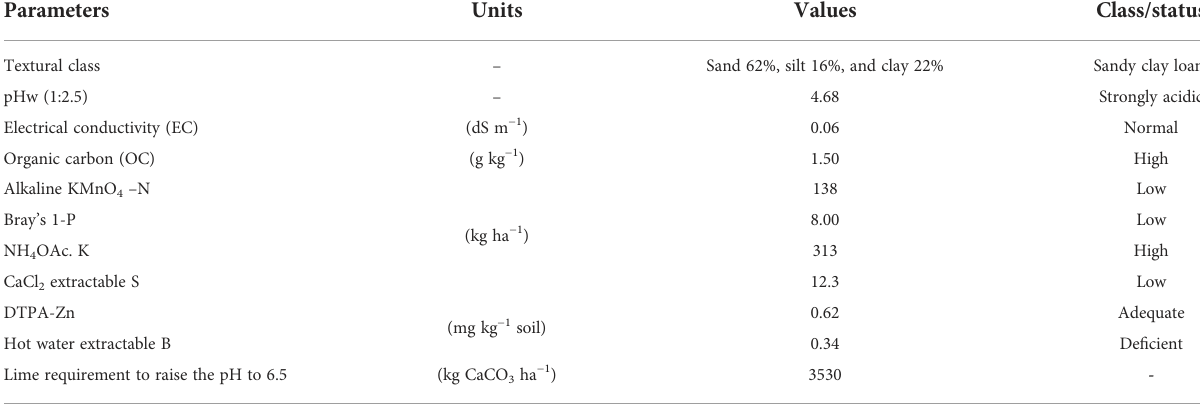
TABLE 4 Initial soil properties of the experimental site.